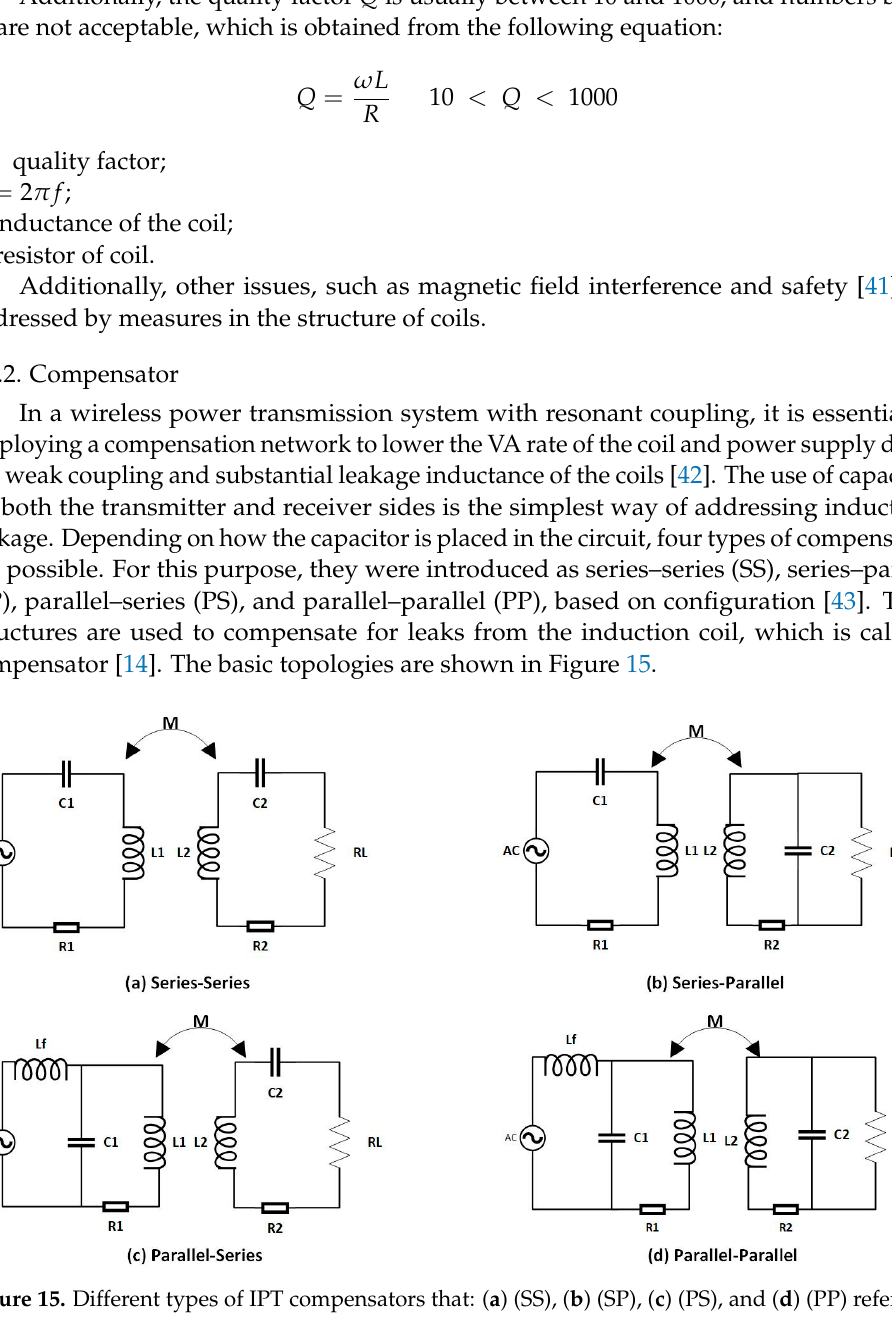
Table 3. Relationships governing the above circuit [44].